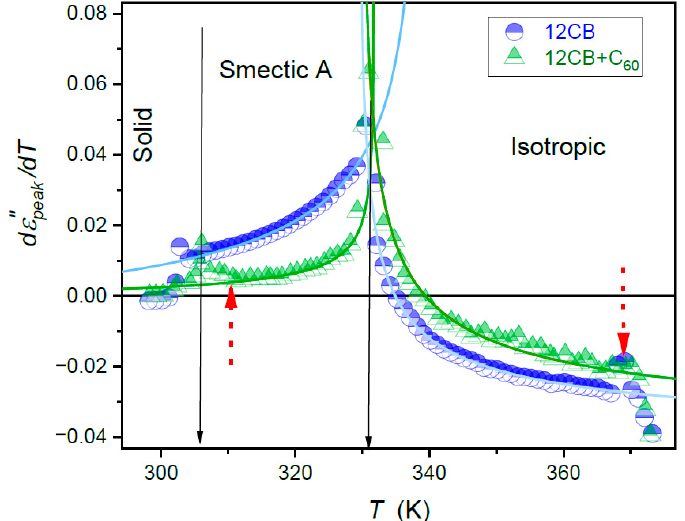
Figure 3. The temperature behavior of the derivative of the dielectric constant in subsequent phases of liquid crystalline 12CB and the composite 12CB + C 60 (0.1%) fullerene. The plot was obtained based on experimental data given in Figure 2. Solid curves are related to Equations (16) and (18). Solid arrows indicate phase transition temperatures. Short, dashed arrows indicate the onset of distortions remote from the I–N transition and near the Sm A – S transition.